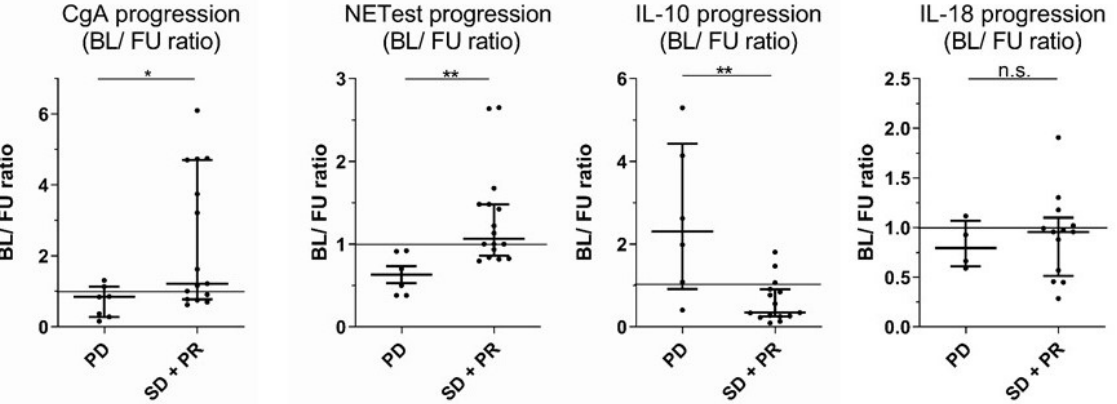
Figure 4. Cytokine ratios may hint at disease progression. Evaluation of disease progression according to the analyte ratio between initial the baseline (BL) and follow-up (FU) for each patient. Shown are patients with PD or the combined group of SD and partial remission (PR) (* p < 0.05, ** p < 0.01). Horizontal bars indicate median and IQR; AUC was automatically calculated using GraphPad Prism.